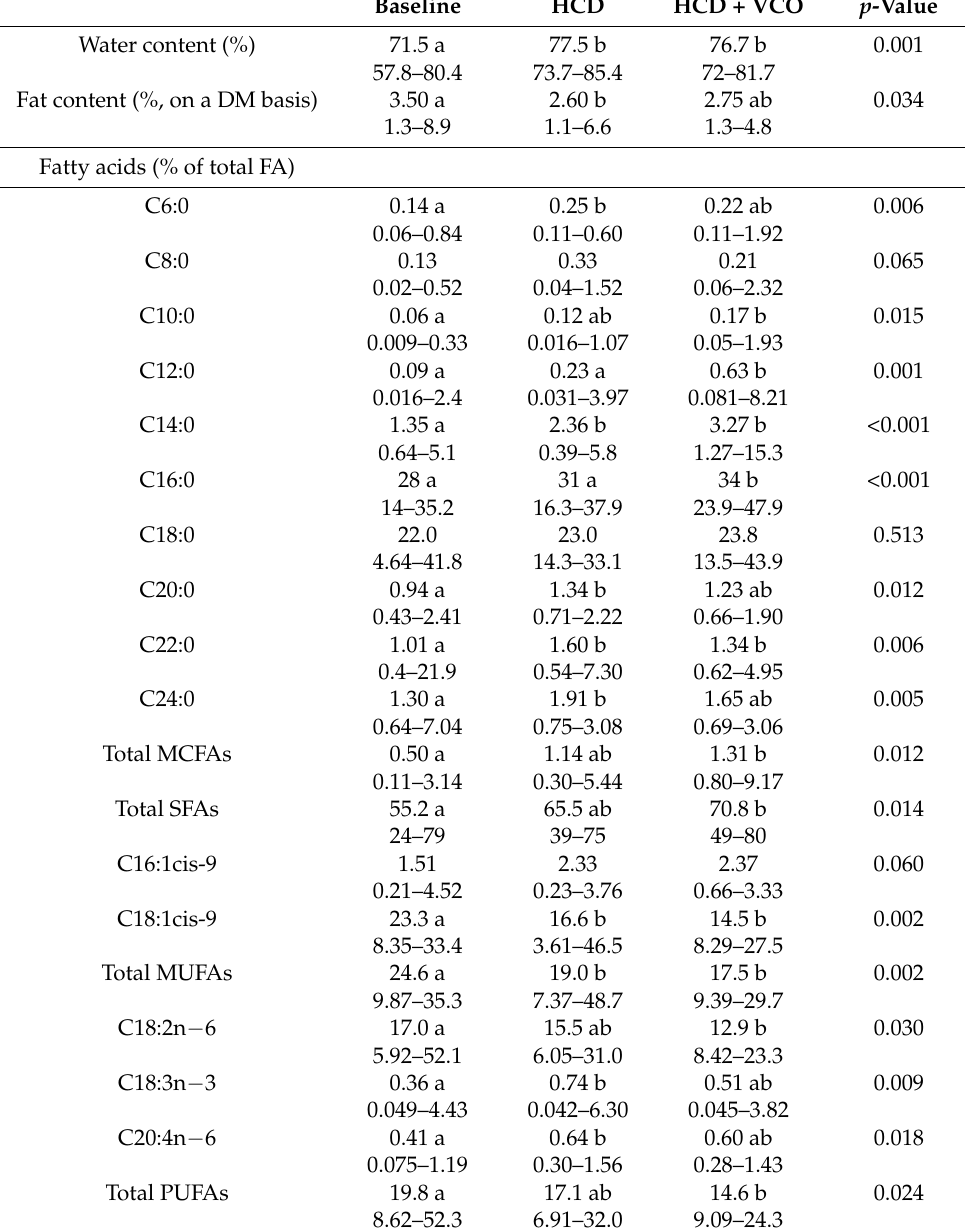
Table 4. Chemical parameters measured in canine fecal samples collected in dogs during the first visit (baseline), after receiving a home-cooked diet for 7 days (HCD), and after supplementation with virgin coconut oil (HCD + VCO). Data are expressed as median and